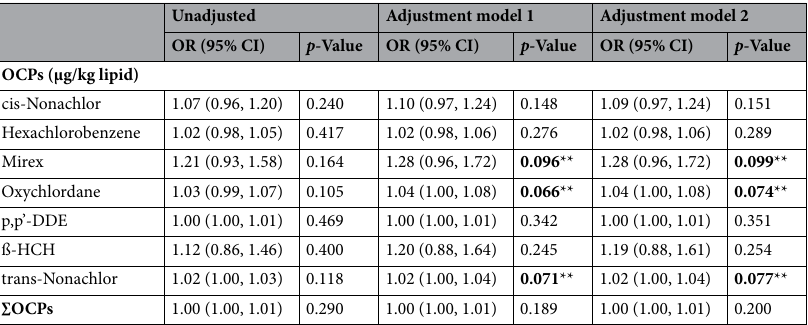
Table 7. Logistic regression analysis of associations between prenatal OCP exposure and abnormal hyperactivity score: Greenlandic children 3–5 years of age born 2014–2016, the ACCEPT birth cohort. Normal/borderline n = 96, Abnormal n = 5, OR odds-ratio, CI confidence interval, Bold text and * = Significant ( p ≤ 0.050), Bold text and ** = Borderline significant ( p ≤ 0.100), Adjustment model 1: Maternal plasma cotinine, maternal educational level, maternal age at delivery, Adjustment model 2: Adjustment model 1 + breast-feeding duration, OCPs organochlorine pesticides.